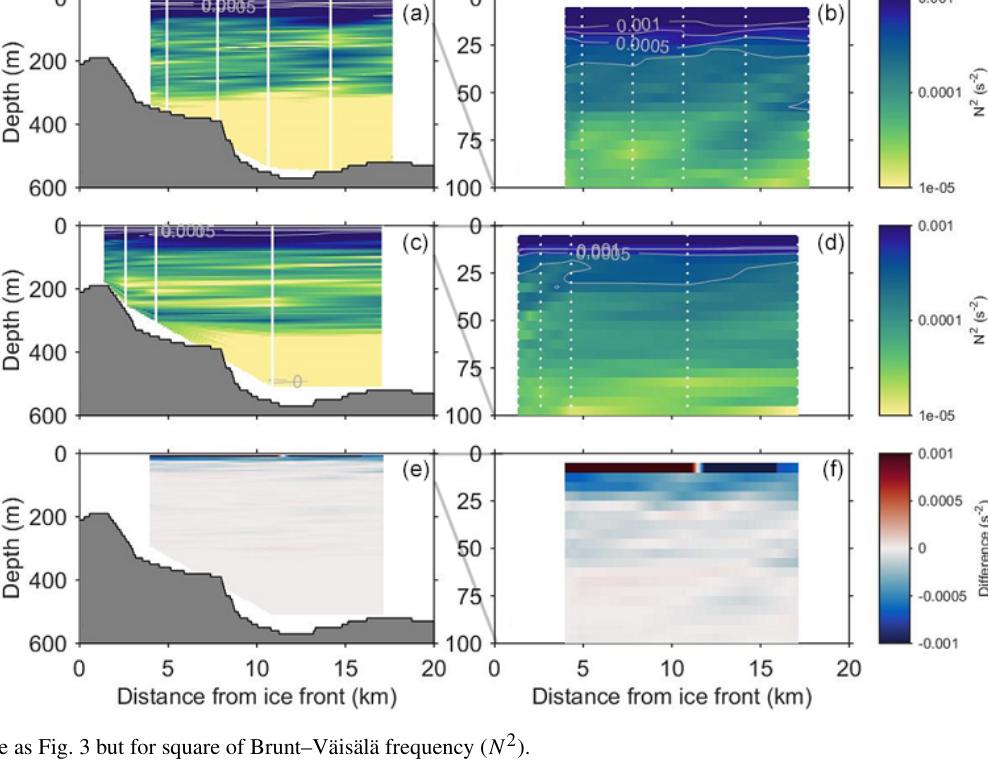
Figure 5. Same as Fig. 3 but for square of Brunt–Väisälä frequency ( N 2 ).